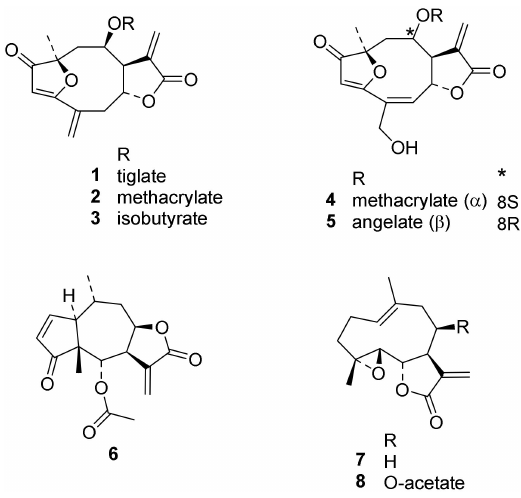
Figure 1. Chemical structures of the sesquiterpene lactones (STLs) tested in this